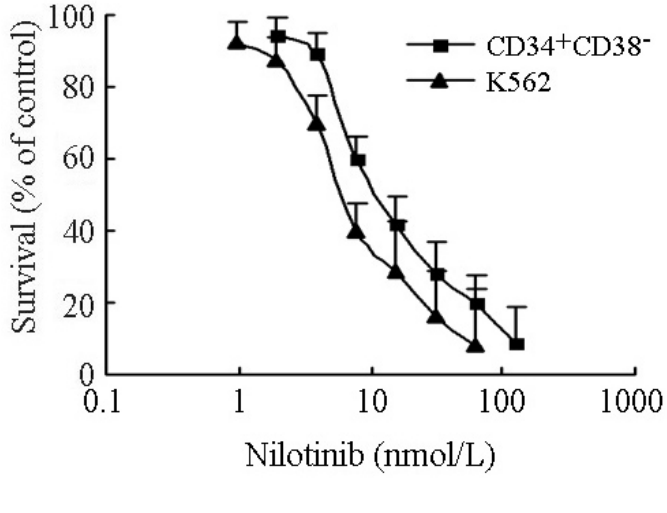
Figure 5. The cytotoxic effect of nilotinib on CD34 + CD38 − and parental K562 cells. The MTT cytotoxicity assay was assessed in CD34 + CD38 − leukemic subpopulation